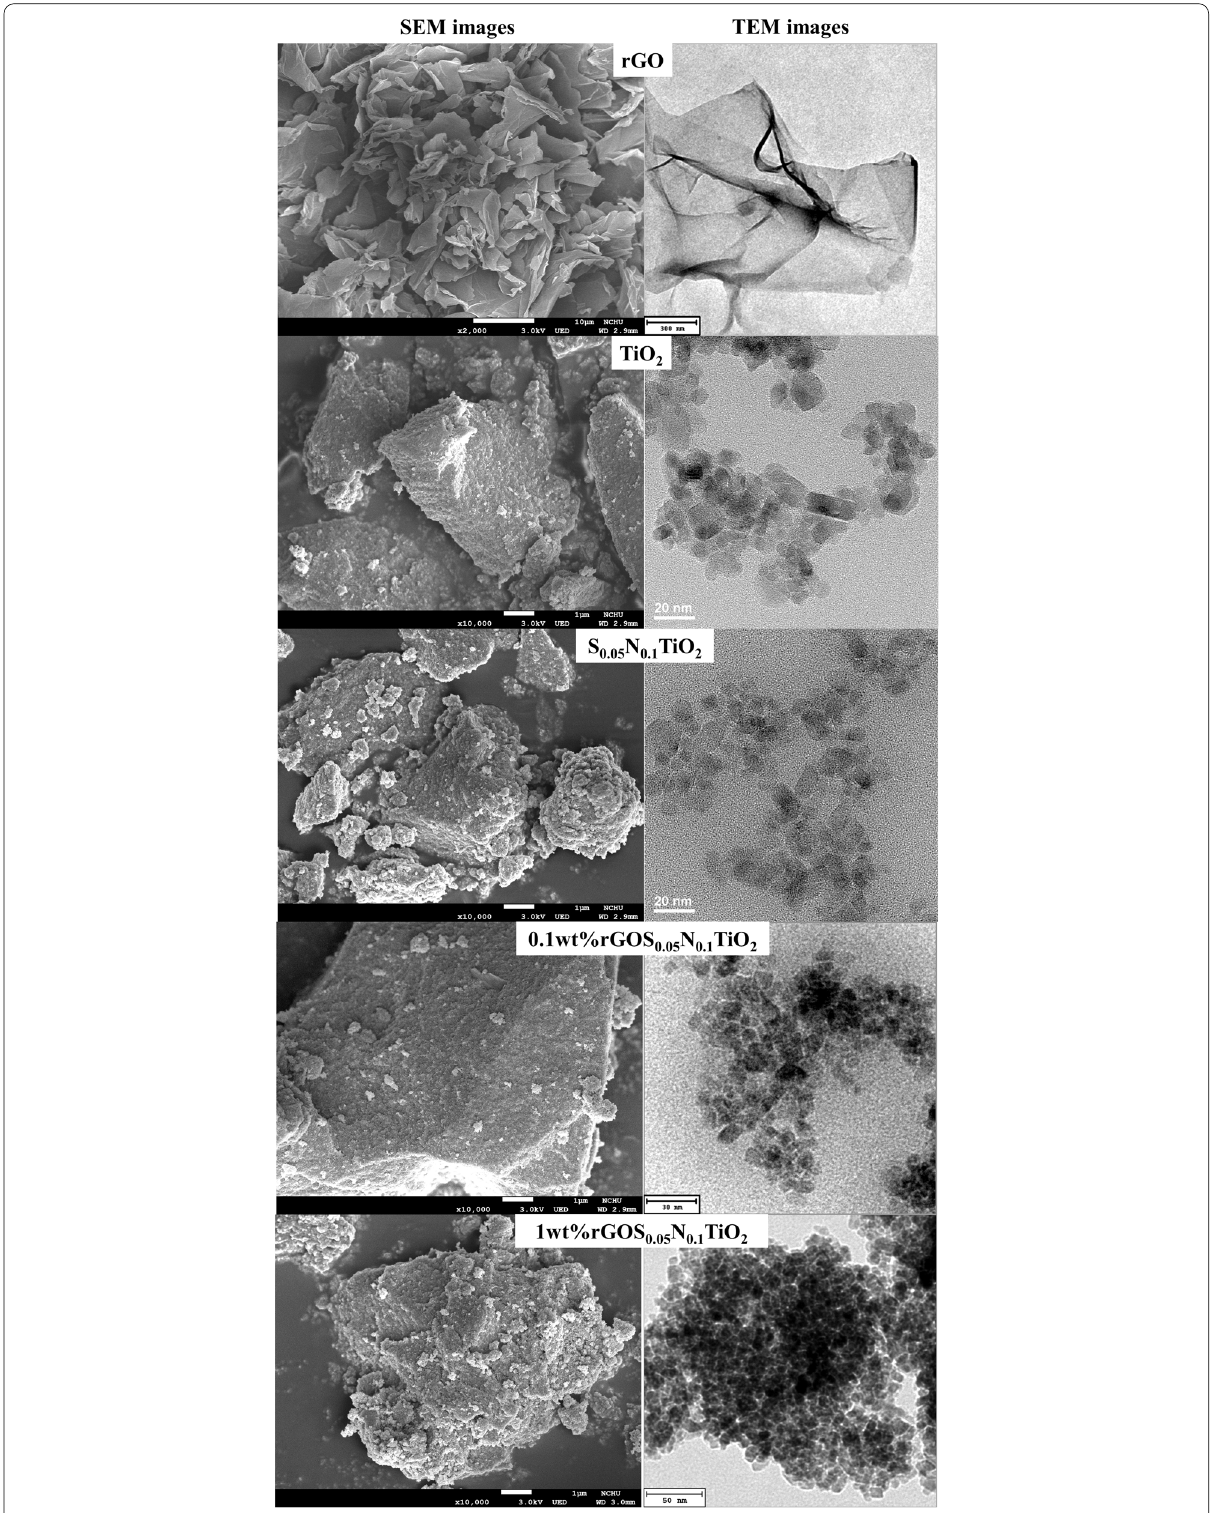
Fig. 2 The SEM and TEM images of various materials and synthesized